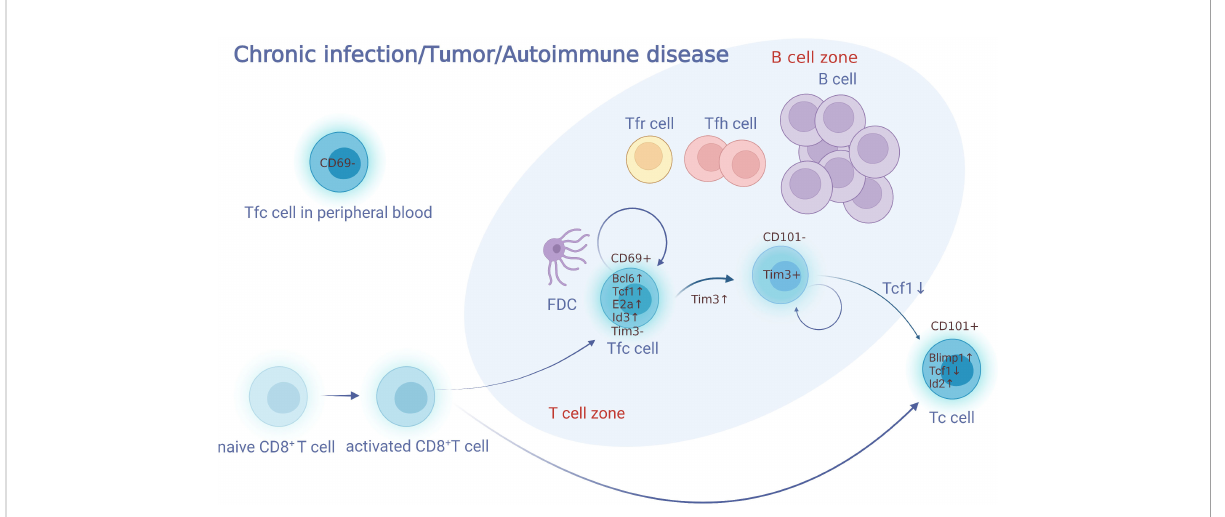
FIGURE 1 Development of Tfc cells. Naïve CD8 + T cells are activated and differentiated into activated CD8 + T cells. A part of activated CD8 + T cells express CXCR5 and migrate to B cell follicles and their surroundings along the gradient of CXCL13 concentration. These cell subsets, de fi ned as Tfc cells, perform various biological functions such as killing, memory, supporting, and regulation. Tfc cells do not express Tim3, and have the ability to self-renew. Tfc cells upregulate Tim3 and differentiate into two groups of Tim3 + CD8 + T cells (CD101 − Tim3 + CD8 + T and CD101 + Tim3 + CD8 + T). CD101 − Tim3 + CD8 + T cells is a transitory cell population, which preserves proliferative and effector activity before transform into effector CD101 + Tim3 + CD8 + T cells irreversibly. Furthermore, Tfc cells present in both of the lymphoid organs and the peripheral blood, with those in the lymphoid organ expressing CD69 while those in the peripheral do not express. FDC, follicular dendritic cell; Tfh, follicular helper; Tc, cytotoxic T; Tfc, follicular cytotoxic